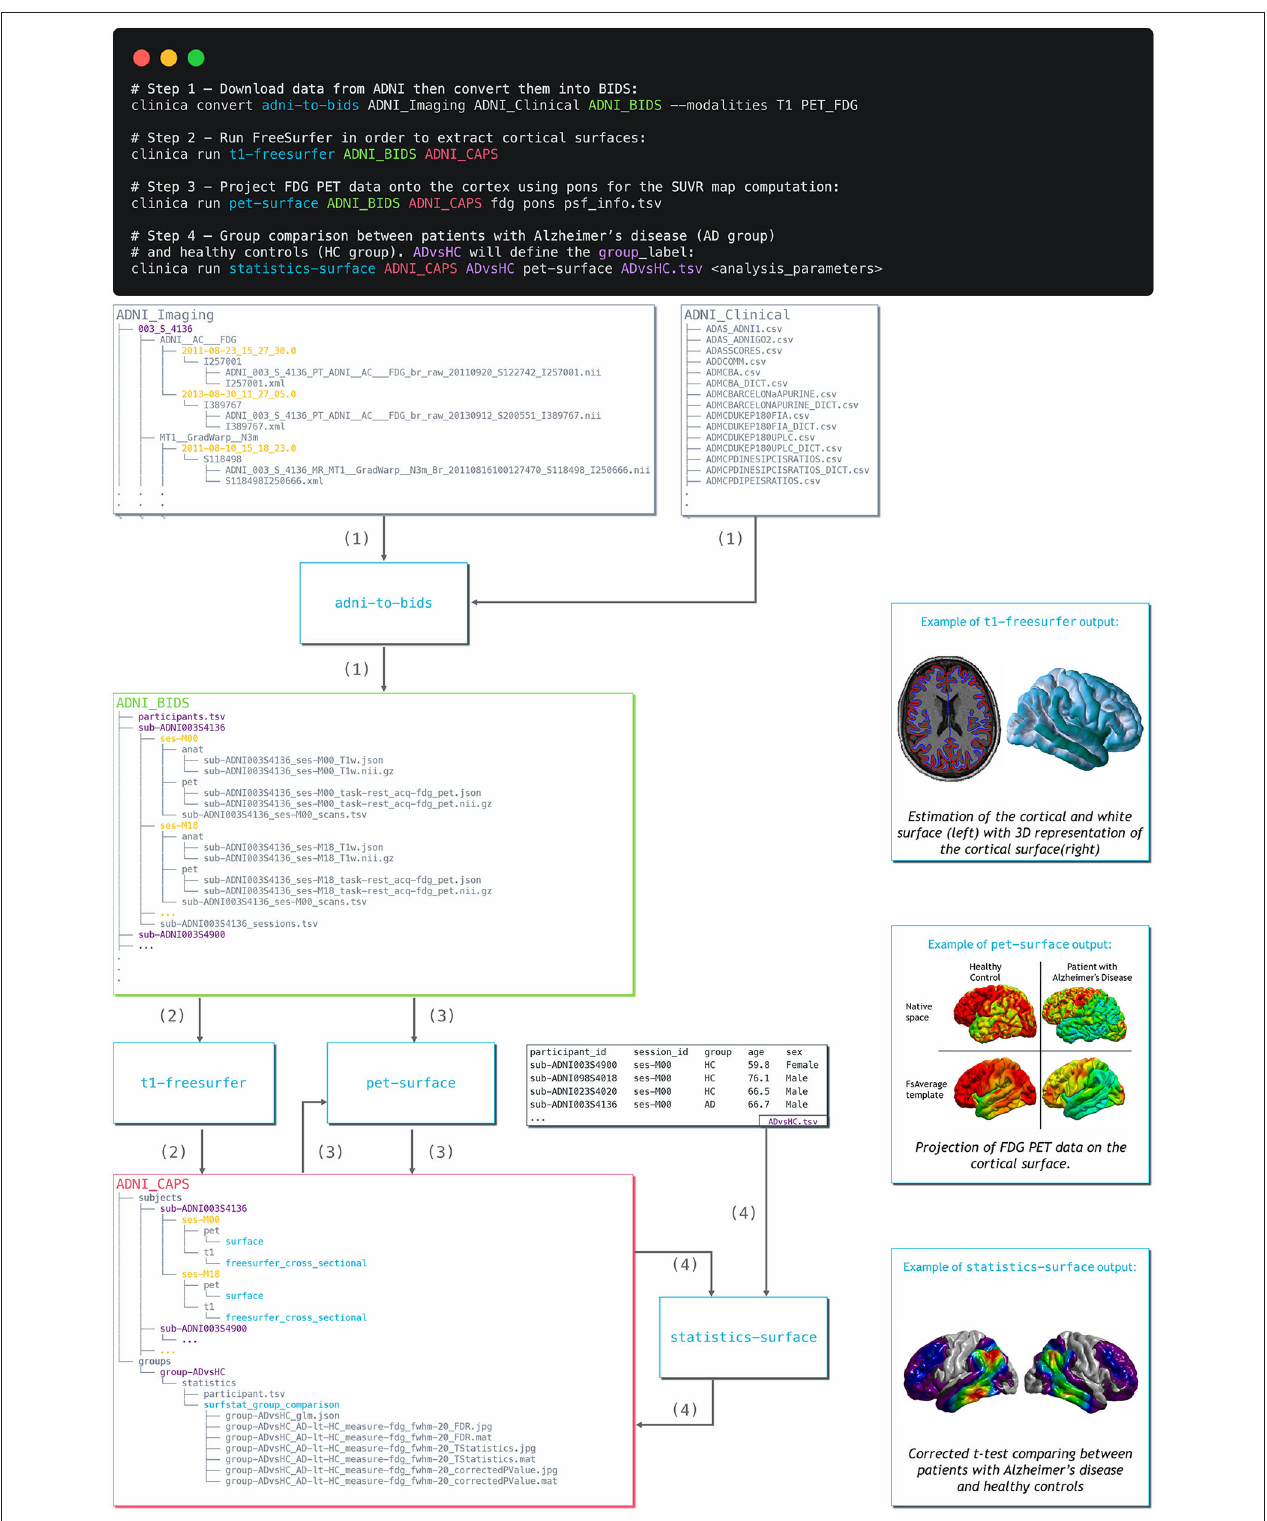
FIGURE 3 | Diagram illustrating the Clinica pipelines involved when performing a group comparison of FDG PET data projected on the cortical surface between patients with Alzheimer’s disease and healthy controls from the ADNI database. First, clinical and neuroimaging data are downloaded from the ADNI website and